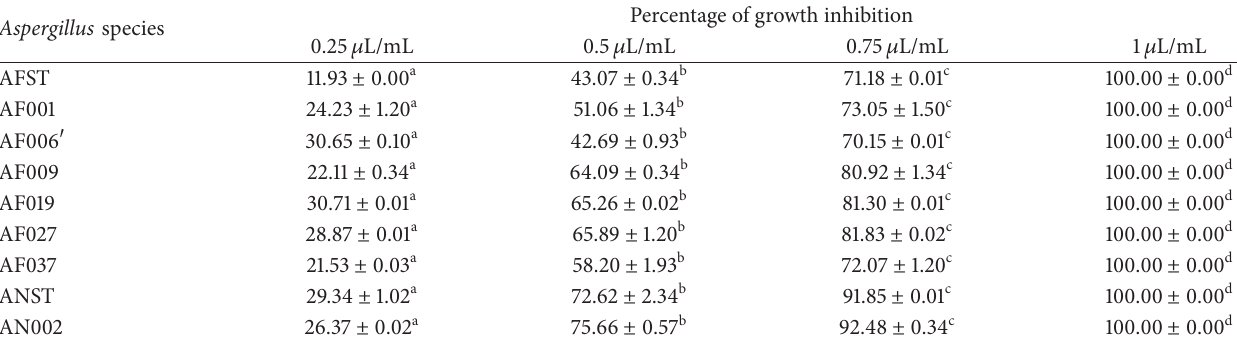
Table 6: Percentage of growth inhibition of Aspergillus species on the basis of dry weight after treatments with different concentrations of Trachyspermum ammi essential oils.